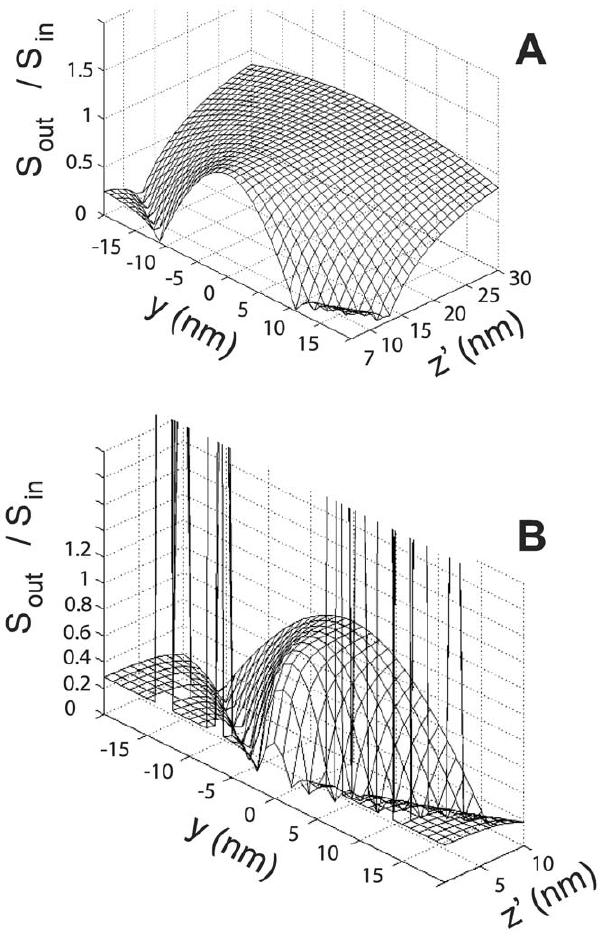
Figure 3. Transmission properties of an optimized-superlens. Fraction of transmitted energy as a function of ‘‘ y ’’ and the dipole- superlens distance ( z ’ ). ( a ) 7 nm v z ’ v 30 nm and ( b ) 2 nm v z ’ v 10 nm. ‘‘ p ’’ has been chosen so that Eqn. 3 is true at z ’ ~ 15 nm. All other parameters are as discussed in text.